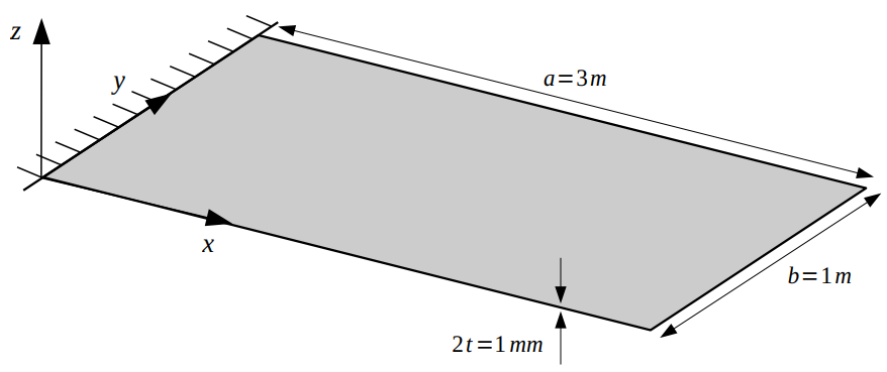
Figure 3. Geometrical dimensions and boundary conditions of the rectangular plate used for the numerical study.